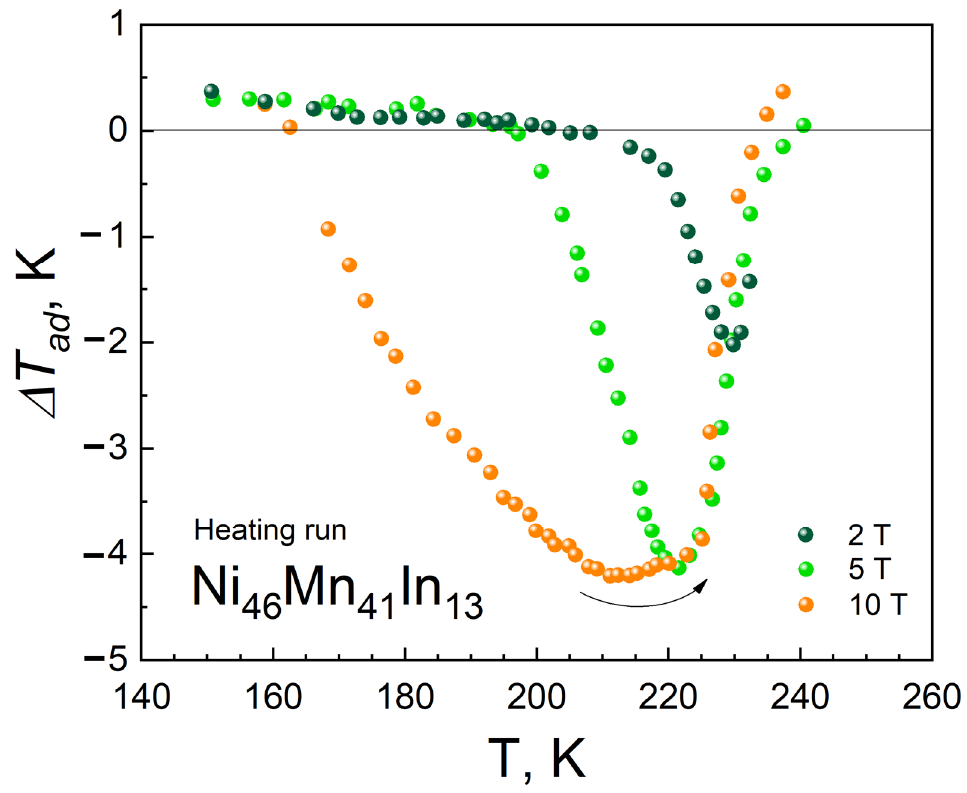
Figure 2. Temperature dependence of ∆T ad obtained upon sequential heating sample in magnetic fields of 2, 5 and 10 T.